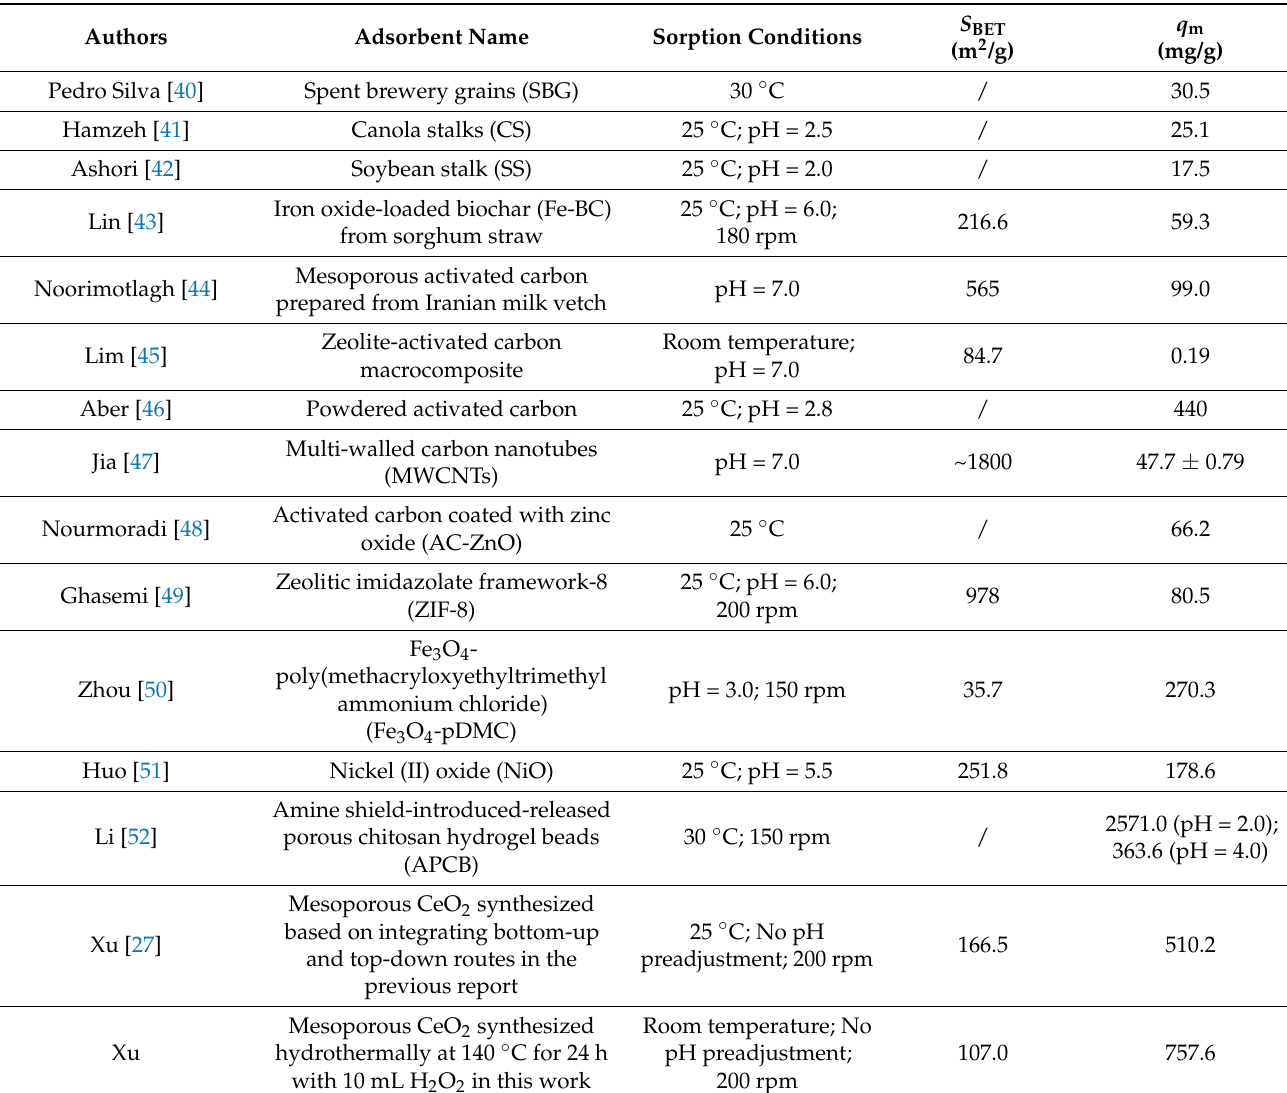
Table 4. Recent literature on adsorbent development for the adsorption of AO7